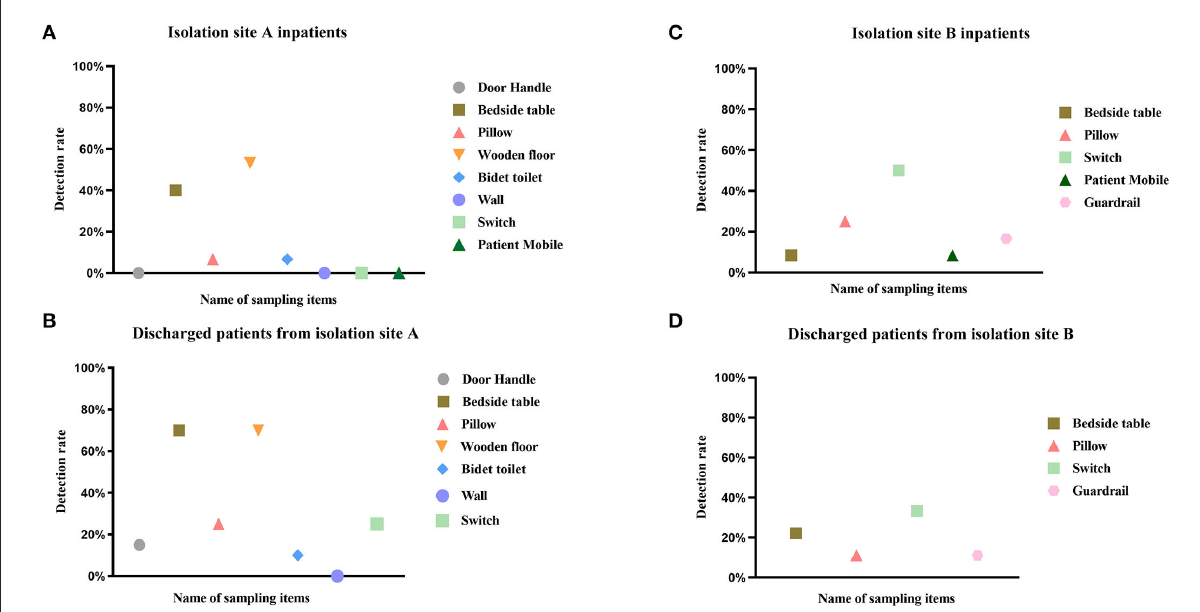
FIGURE1 Detection rate of SARS-CoV-2 RNA in different environmental samples. This figure depicts the detection rate of SARS-CoV-2 RNA in environmental samples of COVID-19 patients hospitalized (A,C) and discharged (B,D) from isolation site A and isolation site B. The positivity rate was calculated as (number of patients with positive specimens)/(total number of patients), and detailed data are shown in Table 1. Different colors represent different sampled items, and the same color is the same category.